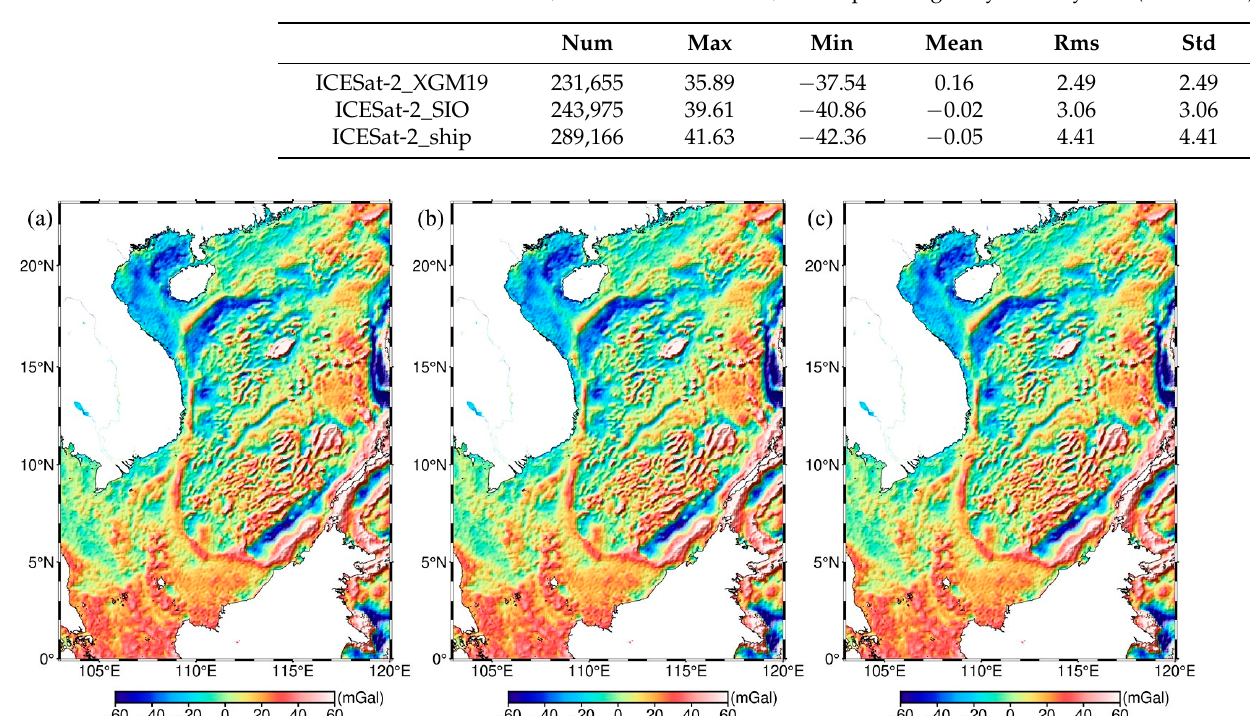
Table 20. Statistics of differences between the joint along-cross DOV-derived gravity anomalies and the